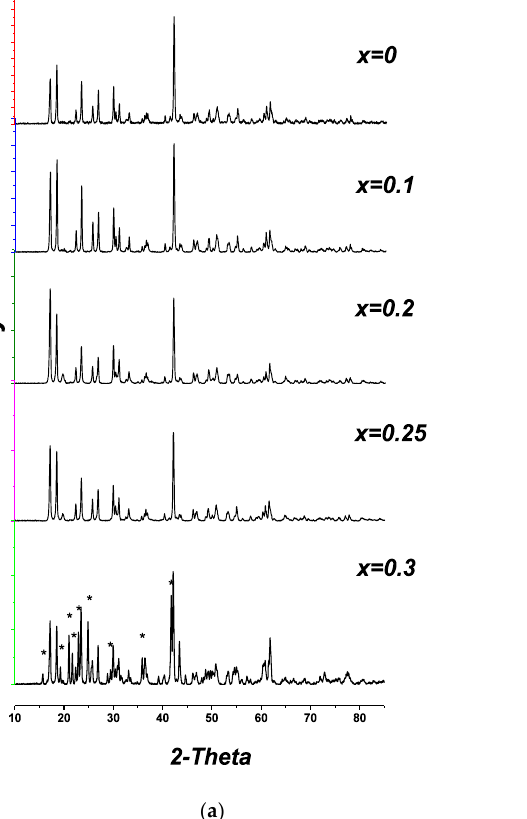
ss indicates solid solutions with the monoclinic structure of Li 6 Zr 2 O 7 .